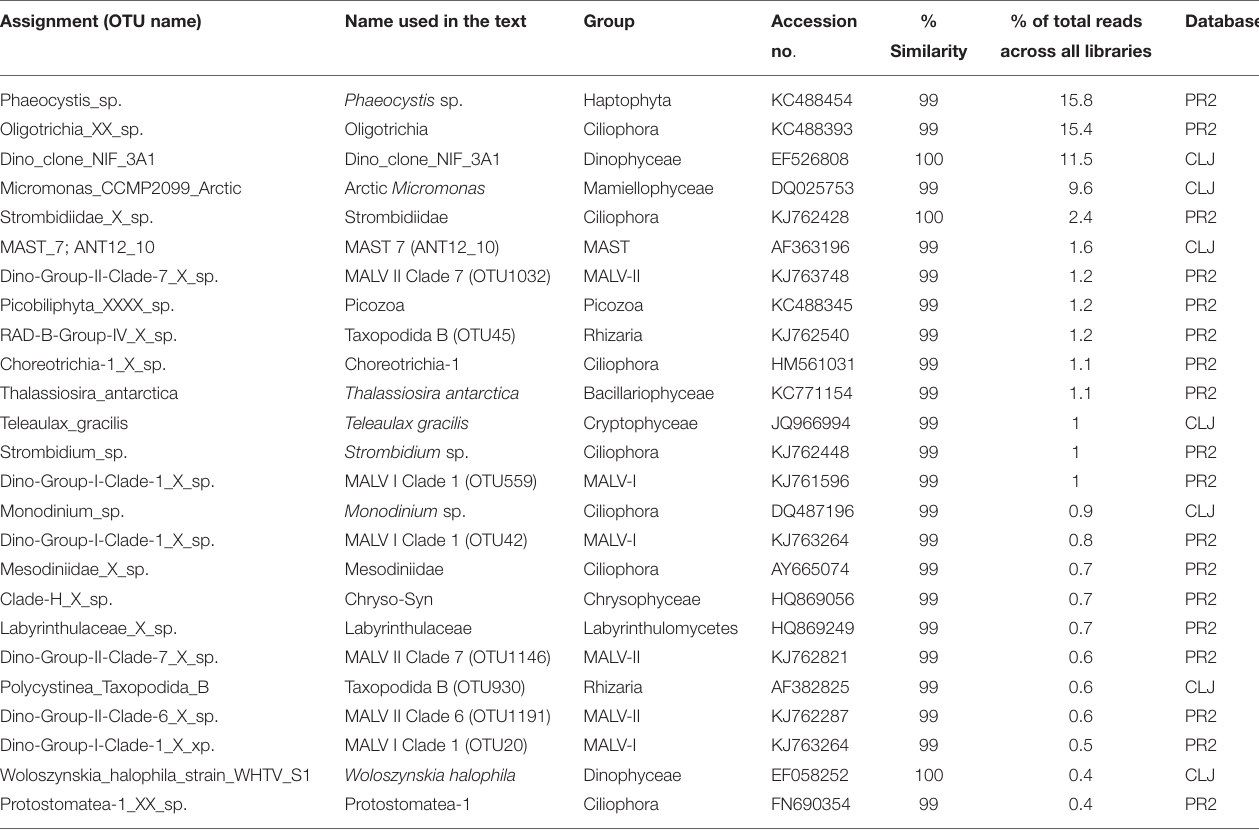
TABLE 2 | Overview of the relative abundances and assignments of the abundant OTUs ( > 1% of total reads and/ or the five most abundant OTUs in each